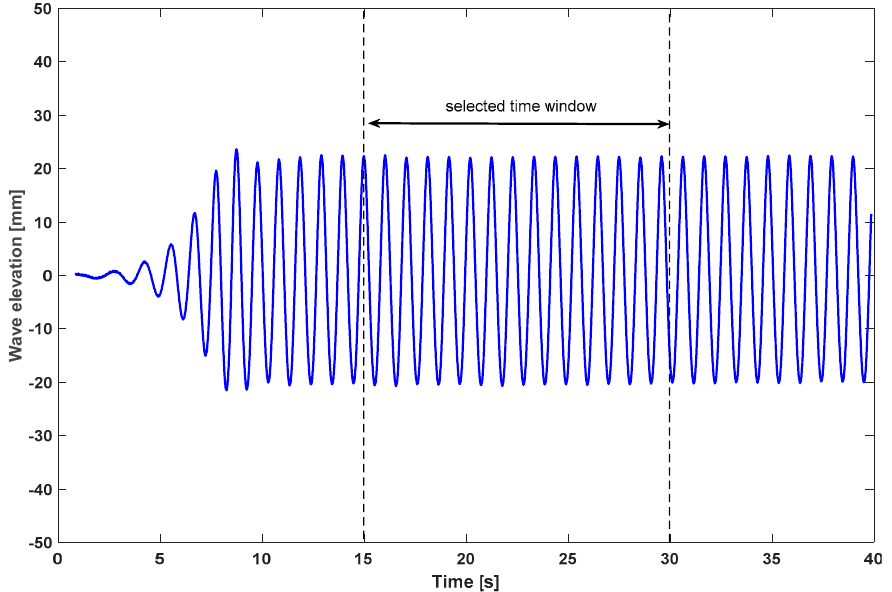
Figure 9. Time history of wave elevation at WP2 and the selected time window for data analysis.